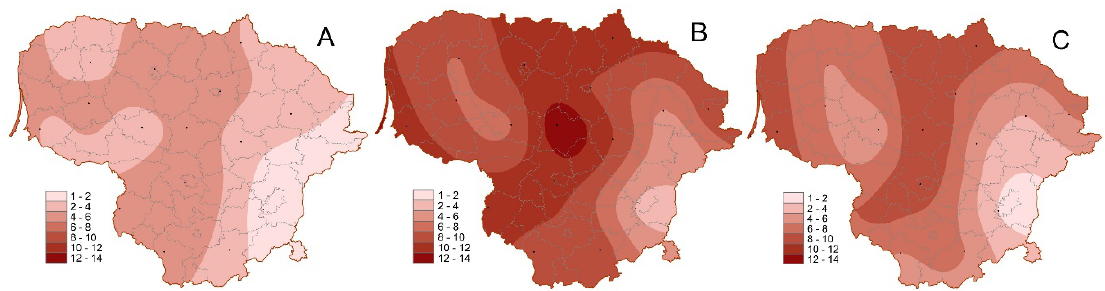
Fig. 6. Reoccurrence of extreme droughts in Lithuania in 1961–2019 according to HTC (A), TPI < 3.5 (B), TPI < 3.0 (C)